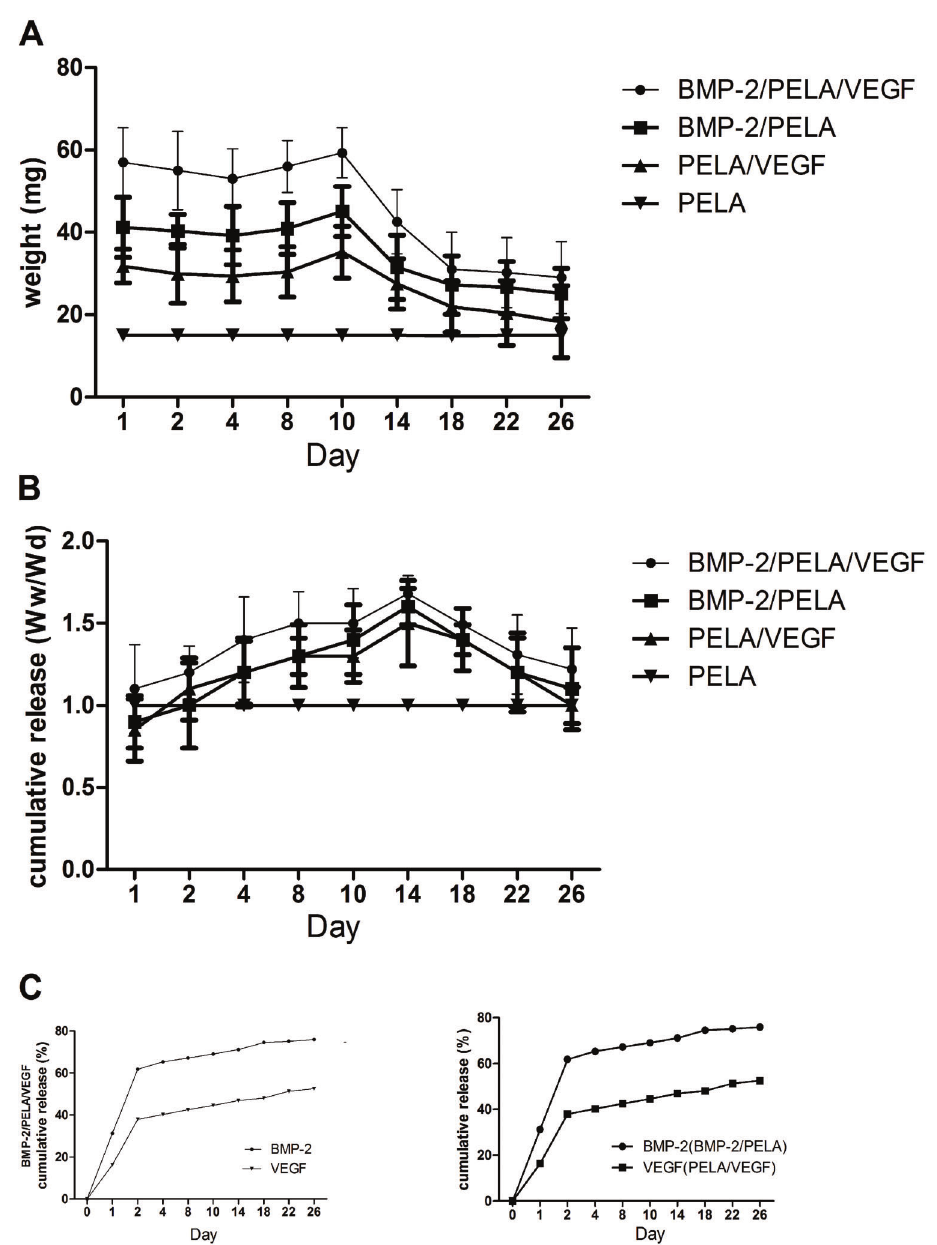
Figure 1. Weight loss ( A ), swelling ratio ( B ) and cumulative release pro fi le ( C ) of BMP-2/PELA/VEGF scaffolds in PBS at 37°C. Data are reported as means ± SD. BMP-2: bone morphogenetic protein-2; PELA: polylactide-poly (ethylene glycol)-polylactide; VEGF: vascular endothelial growth factor; Ww: wet weight; Wd: dry 12% gels and transferred to nitrocellulose membranes for immunoblotting analysis. Membranes were blocked and incubated with primary antibodies overnight at 4°C. Mem- branes were subsequently washed three times with PBS and incubated with peroxidase-conjugated secondary antibodies. Immunoreactive bands were detected with